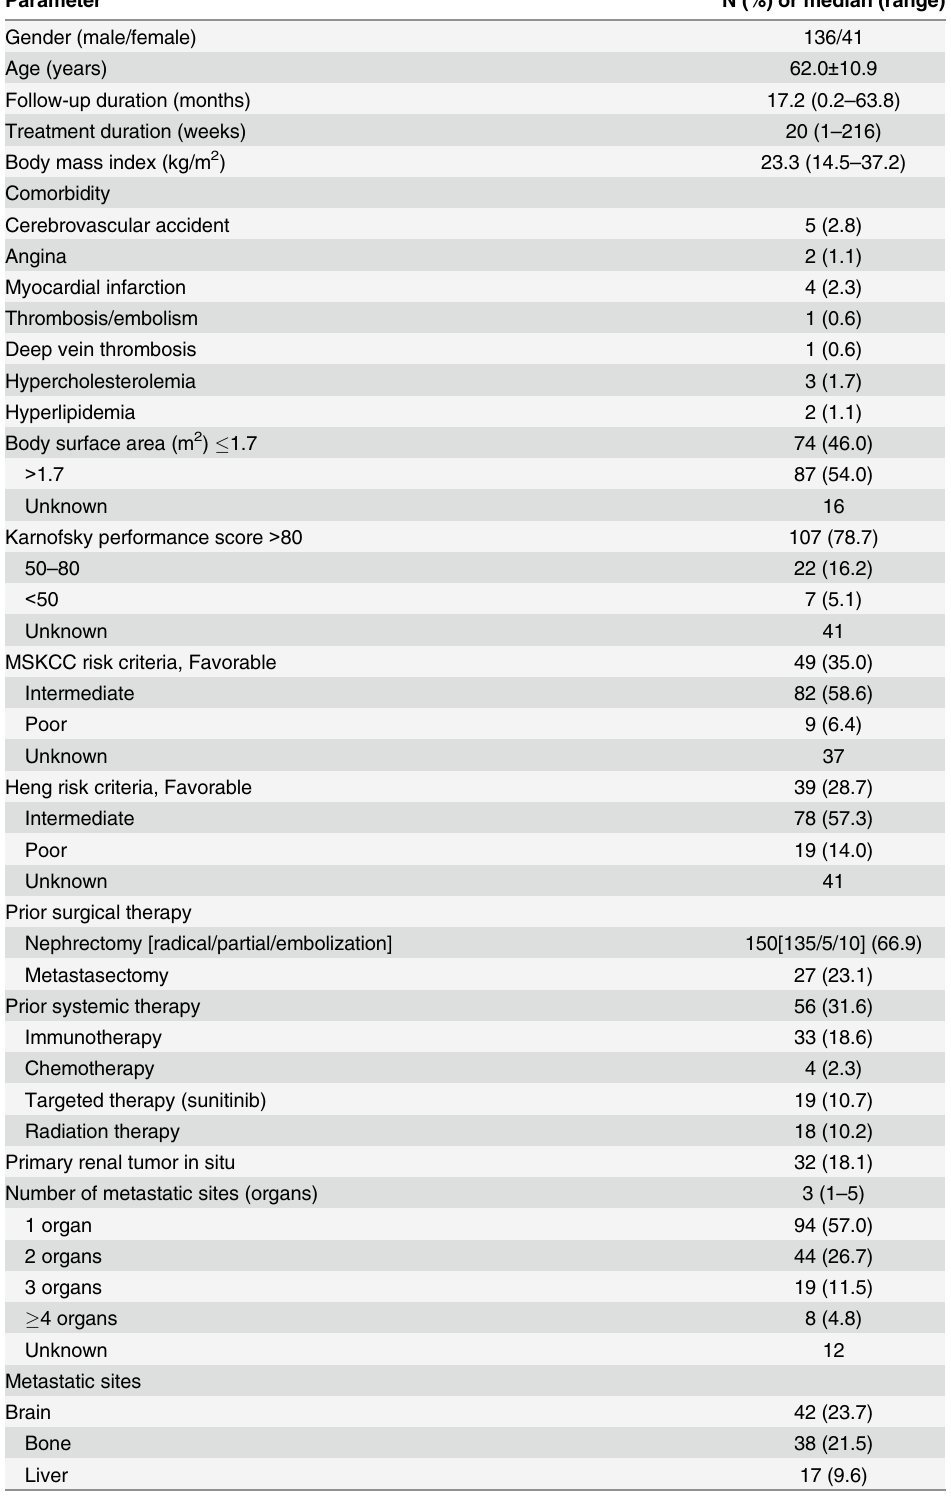
Table 1. Baseline characteristics (N =